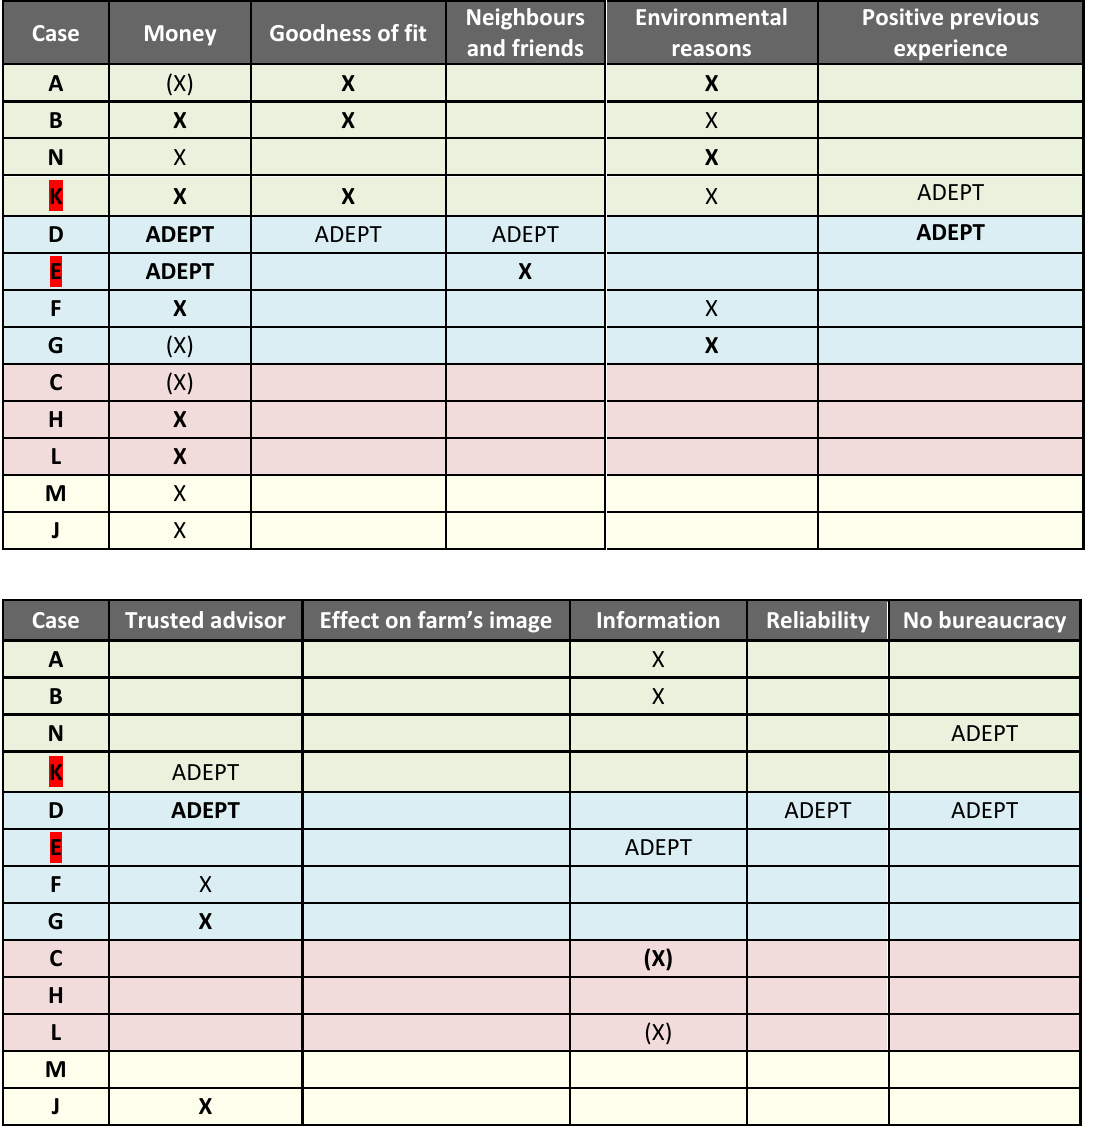
Table 3: Manifestations of Motivations for Participation Green: participants (group 1); blue: participants (group 2); red: drop-outs (groups 3 and 4); yellow: non-participants; highlighted red: APIA drop-outs who switched to ADEPT Bold: main considerations; ADEPT: for ADEPT program only; () = not stated explicitly